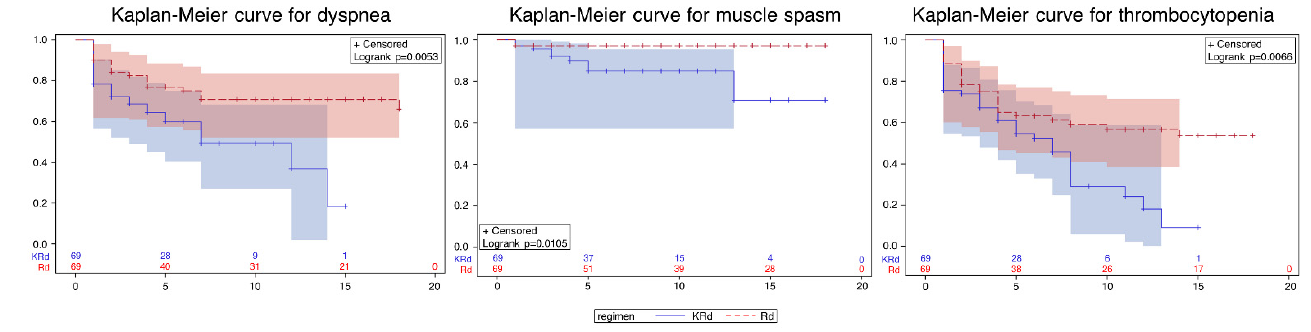
Figure 3. Kaplan–Meier curve for each adverse event. KRd—combination regimen of carfilzomib, lenalidomide, and dexamethasone; Rd—combination regimen of lenalidomide and dexamethasone. When the results of the original RCT (ASPIRE trial) and RWE were compared (Figure S1), cardiovascular disease-related side effects were similar in the direction and significance of the results (each risk (CI) in the RCT and RWE = 1.19 [0.70–2.00]: 1.3 [0.53–3.16]